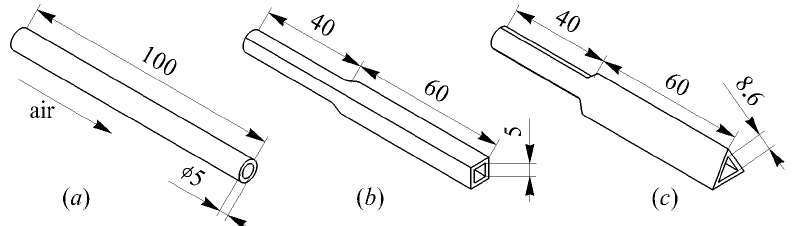
Figure 2. Plan view and key dimensions of the tubes for supplying air to the vertical diffuser: ( a )— circular tube; ( b )—tube with square cross section; ( c )—tube with triangular cross section.